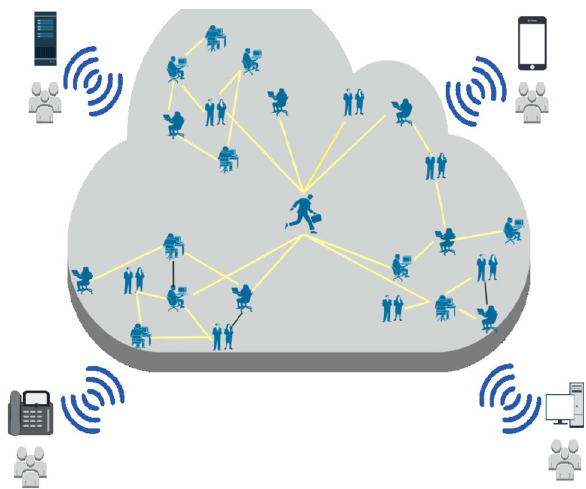
Fig. 1 An illustration of social network neighborhood. In this social network, everyone can influence others or be influ- enced by online neighbors. The yellow lines represent the interaction or friendship link between different social media